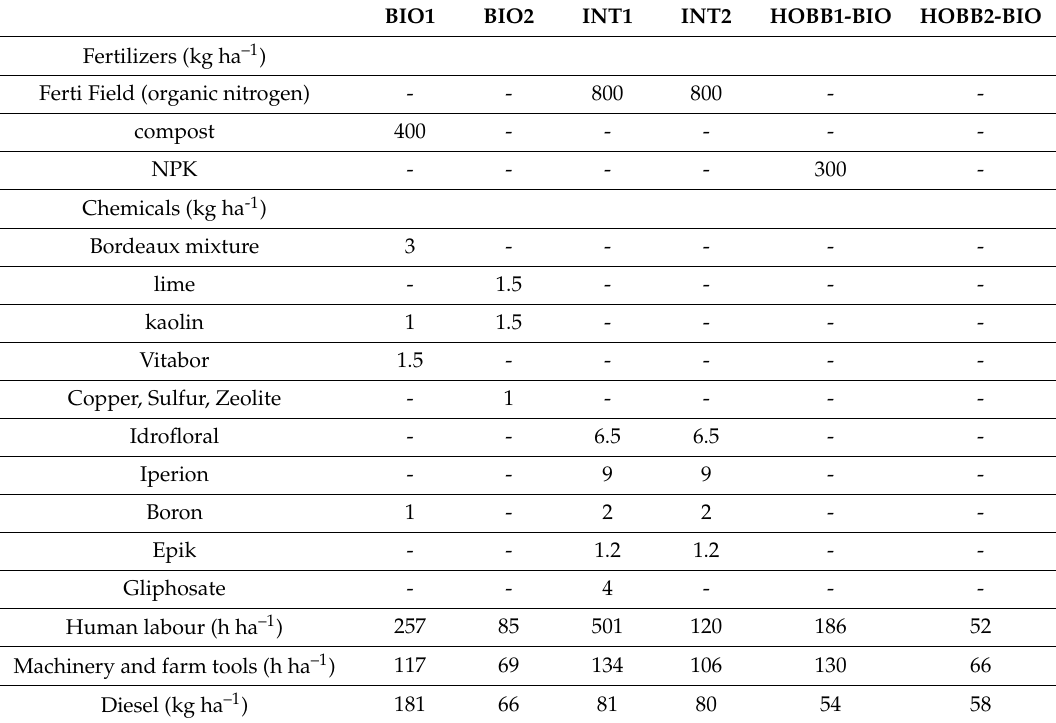
Table 2. Farm inputs used in the analyzed systems.